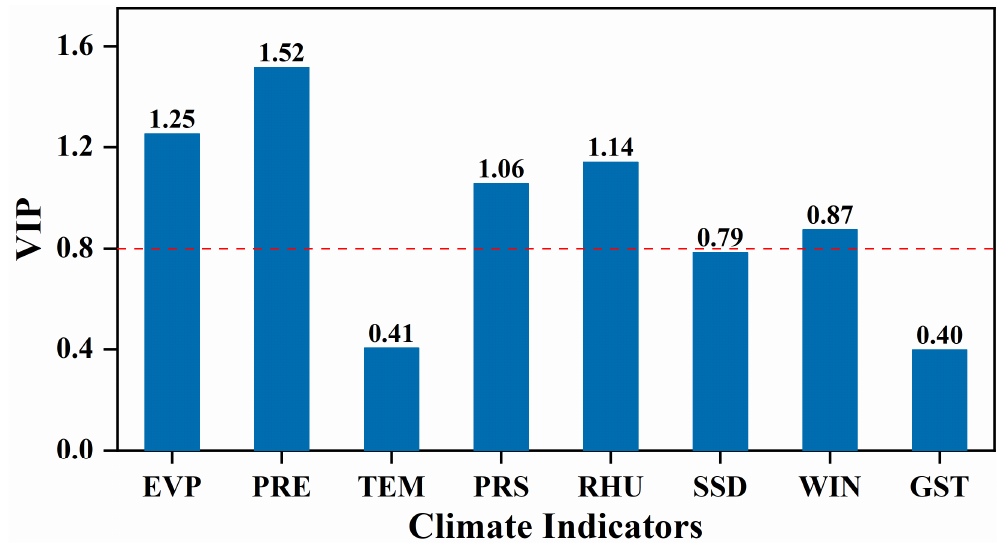
Figure 8. The impact of different climate indicators to drought based on the partial least square regression model over Southwest China from 2003 to 2016.